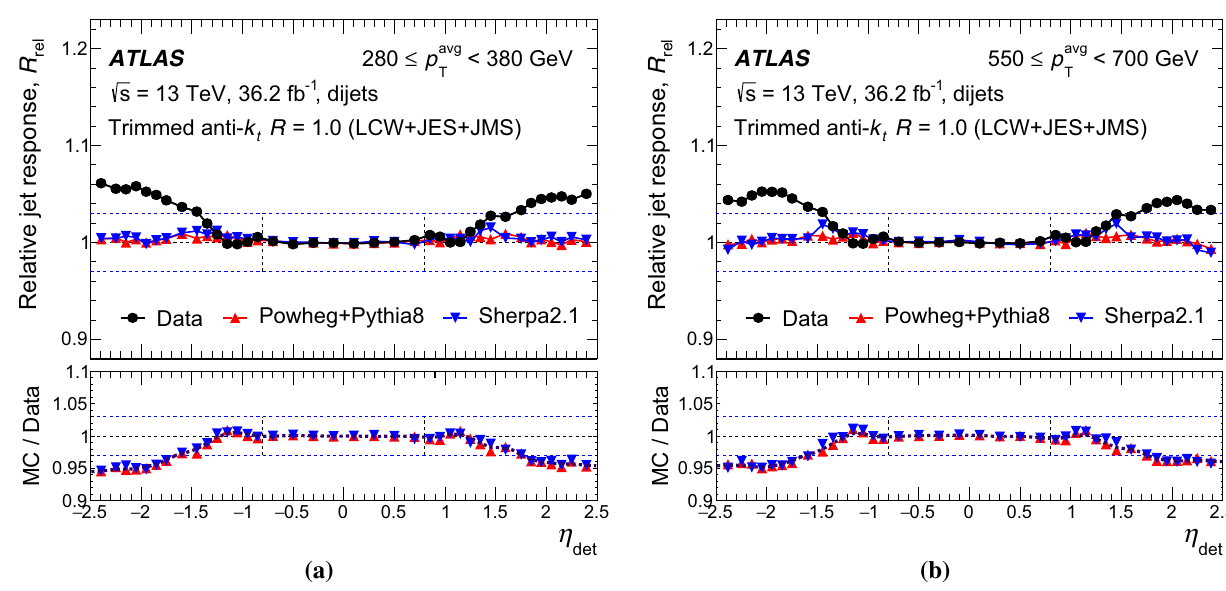
Fig. 4 The relative large- R jet response R rel as a function of the large- ence region | η det | < 0 . 8 is unity by construction. In the lower panels, R jet detector pseudorapidity η det in two representative average trans- the dotted lines interpolating between Powheg + Pythia markers are < 380 GeV and b obtained by smoothing with a filter using a sliding Gaussian verse momentum p avg bins a 280 GeV < p avg T T < 700 GeV. The average response with in the refer- 550 GeV < p avg T